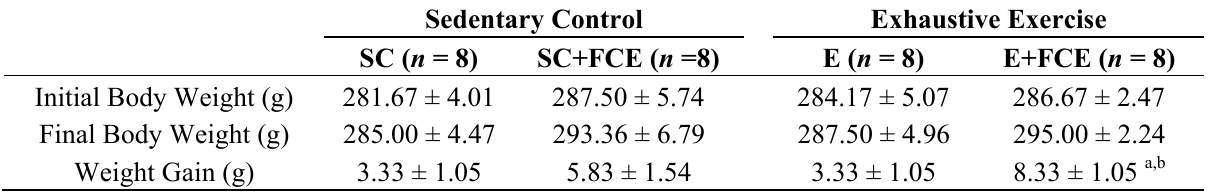
Table 1. Comparative body weight changes in different groups of